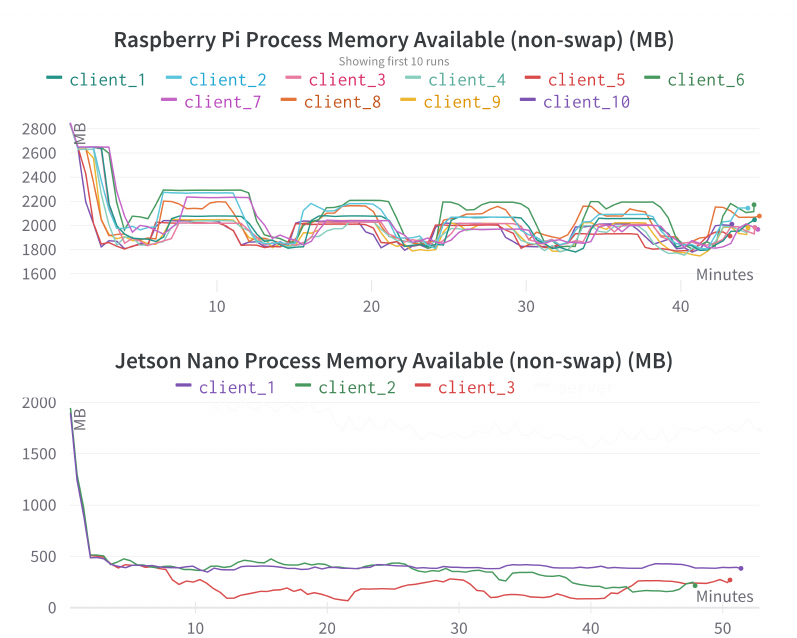
Figure 12. Process memory available comparison for different Raspberry Pi and Jetson Nano devices. The x-axis represents the time in minutes, the y-axis represents the available process memory in megabytes (MB).